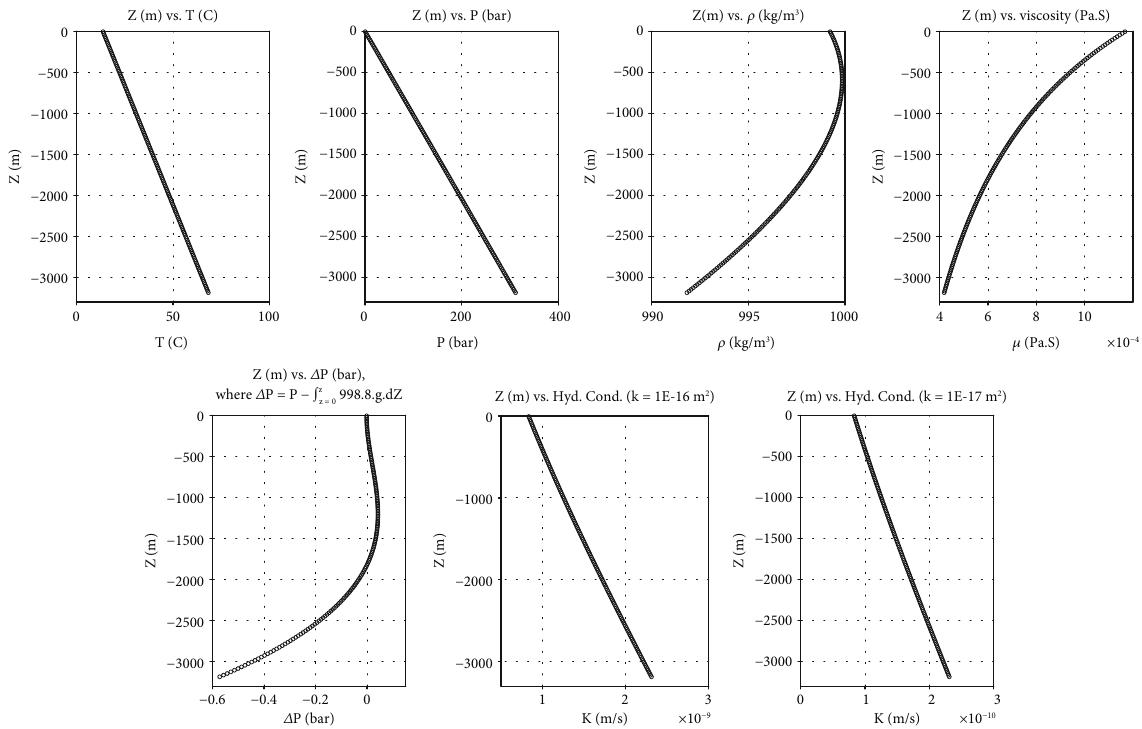
Figure 5: Top row (a – d): depth distribution of background temperature, hydrostatic pressure, water density, and viscosity. Bottom row (e – g): di ff erence between the real and hydrostatic (constant density) pressure and hydraulic conductivity for two di ff erent intrinsic permeability values ( k ). Table 3: The depth-wise dependency of the hydrodynamic parameters, as depicted in Figure